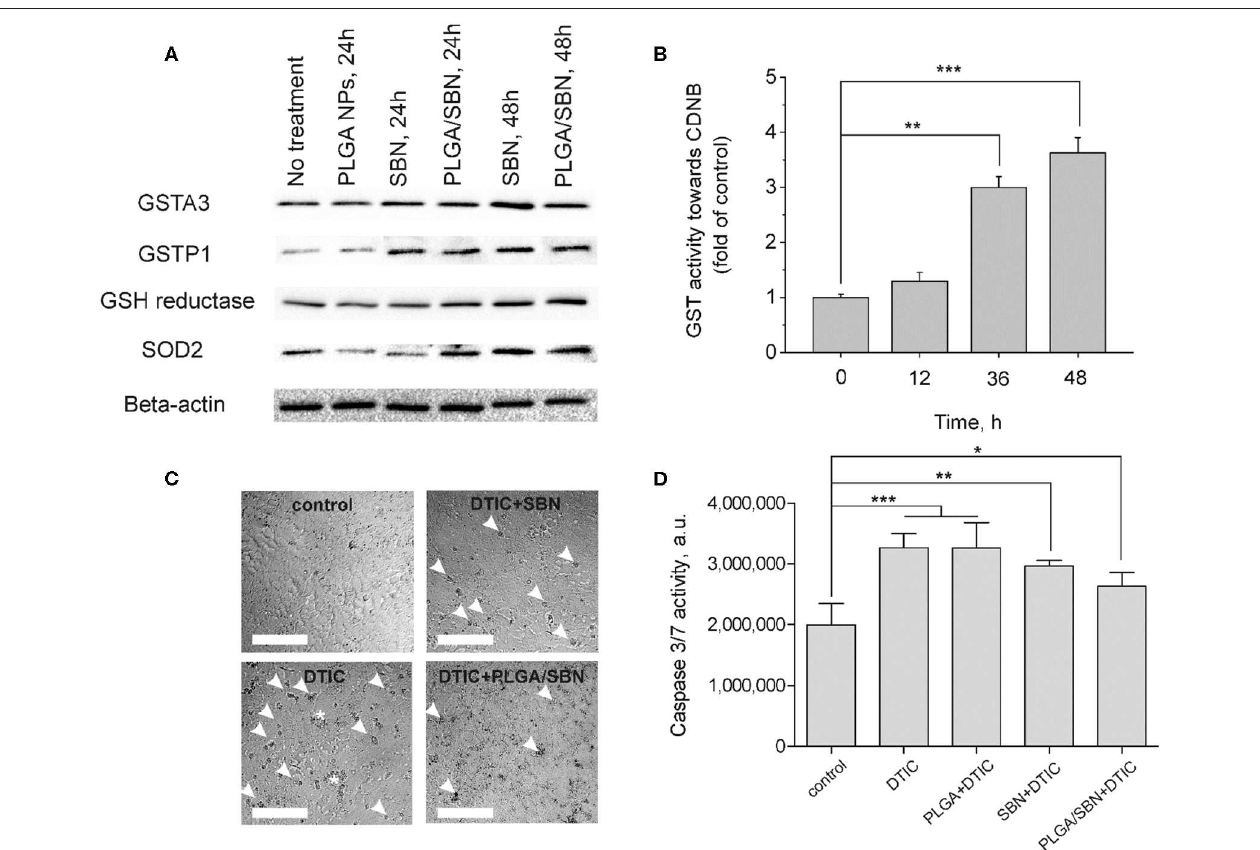
FIGURE 2 | Induction of antioxidant response enzyme expression and hepatoprotective effect by SBN formulations in AML12 hepatocytes. (A) Western blotting analysis of liver enzyme expression in AML12 hepatocytes after treatment with blank PLGA nanoparticles, free SBN and PLGA/SBN nanoparticles. (B) GST activity kinetics in AML12 cells, incubated with 100 µ M SBN, measured using CDNB assay. (C) Images of AML12 cells demonstrating antiapoptotic effect of free SBN or PLGA/SBN nanoparticle pre-treatments during incubation with 0.5mM DTIC. White arrowheads point out single apoptotic cells, whereas white stars denote aggregations of apoptotic cells. Scale bar is 100 µ m. (D) Reduction of caspase 3/7 activation in pre-treated with SBN-containing formulations AML12 cells during incubation with DTIC. All values are shown as means ± SD. * P < 0.05, ** P < 0.01, *** P < 0.001 (one-way ANOVA followed by a post-hoc Dunnett’s t -test) for (B,D)